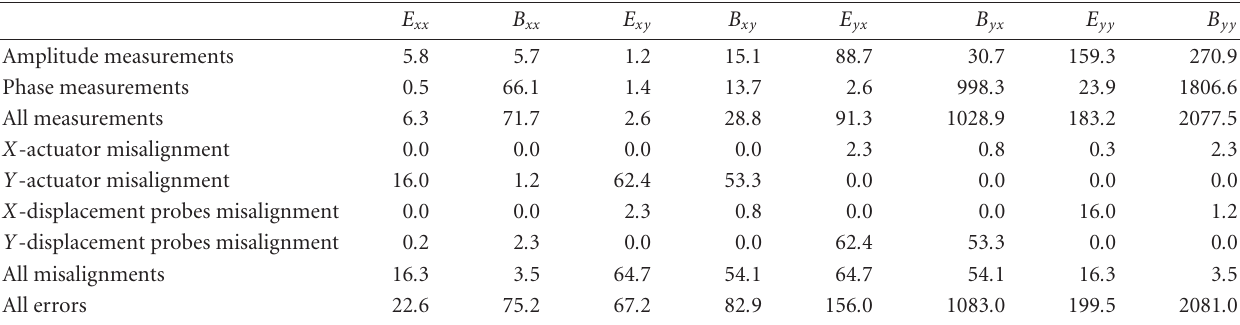
Table 3: Summary of error results. Note that individual measurement errors are 1% / 0 . 01 radian, individual misalignments 0 . 01 radians in the XY plane. Error fig is (change in coe ffi cient ◦ 100)ˆ2 to 1 decimal place.